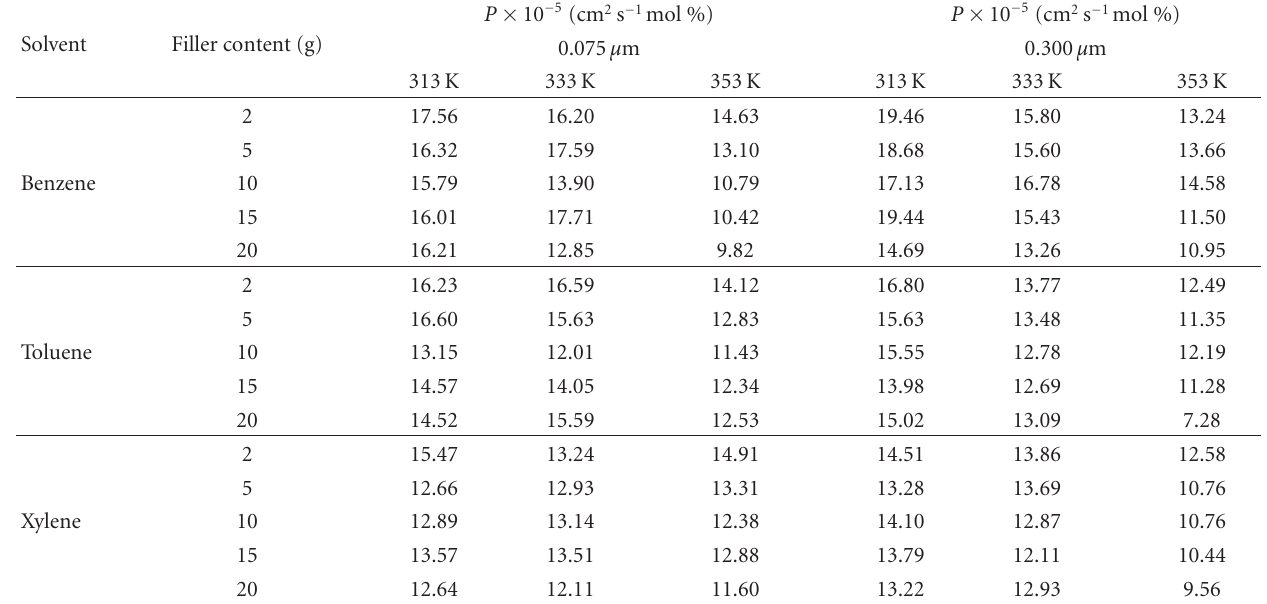
Table 4: Values of the permeability coe ffi cient ( P ) for snail shell powder filled natural rubber at di ff erent temperatures (filler particles sizes 0.075 and 0.30 μ